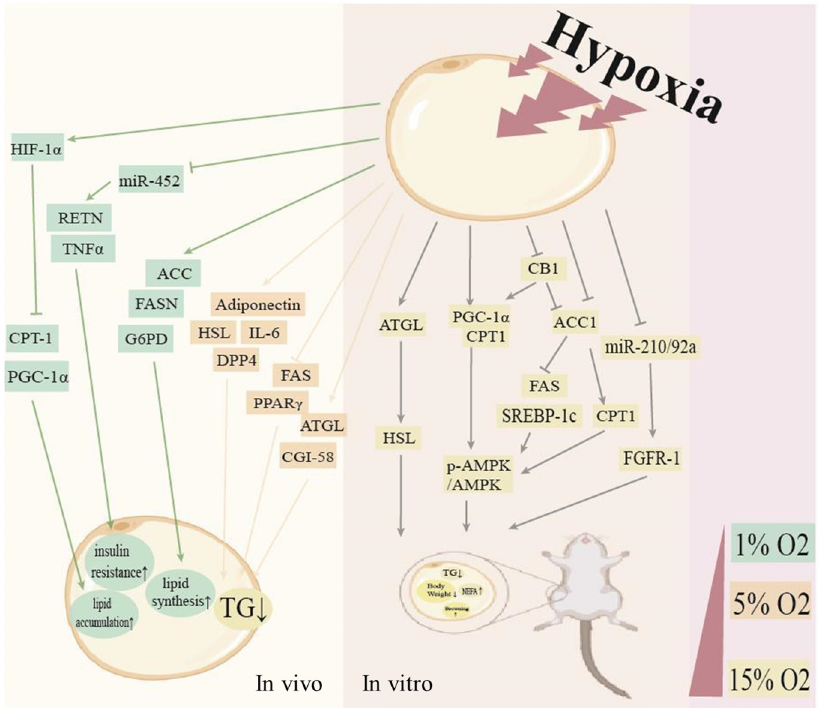
Figure 2. Changes in adipocyte pathways under different hypoxic interventions. In in vitro studies of cellular responses to hypoxic, 1% O 2 is usually used. This was considered as severe hypoxic, as well as acute irritation to the body. However, this was only an extreme case of the mechanism being used to prove. Usually, the body will adapt to the severe hypoxic, and, meanwhile, different concentrations of O 2 in adipose tissue will induce changes in different signaling pathway with distinct outcomes. Different colors represent different oxygen